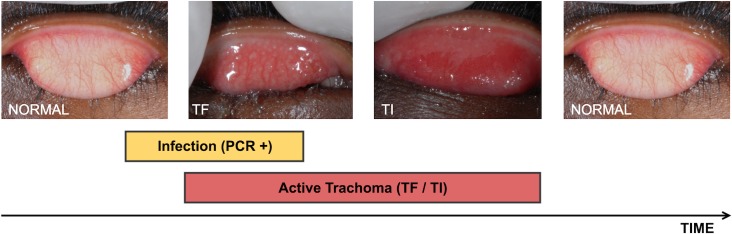
The natural history of an episode of ocular C. trachomatis infection and the associated conjunctival inflammatory response.Trachomatous Inflammation–Follicular (TF): the presence of five or more follicles in the upper tarsal conjunctiva. Trachomatous Inflammation–Intense (TI): pronounced inflammatory thickening of the upper tarsal conjunctiva that obscures more than half of the normal deep tarsal vessels [2].